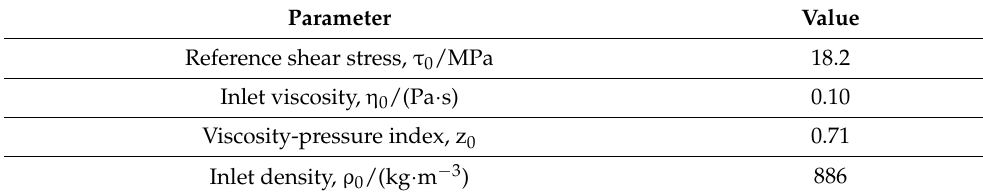
Table 2. Performance parameters of lubricating oil.